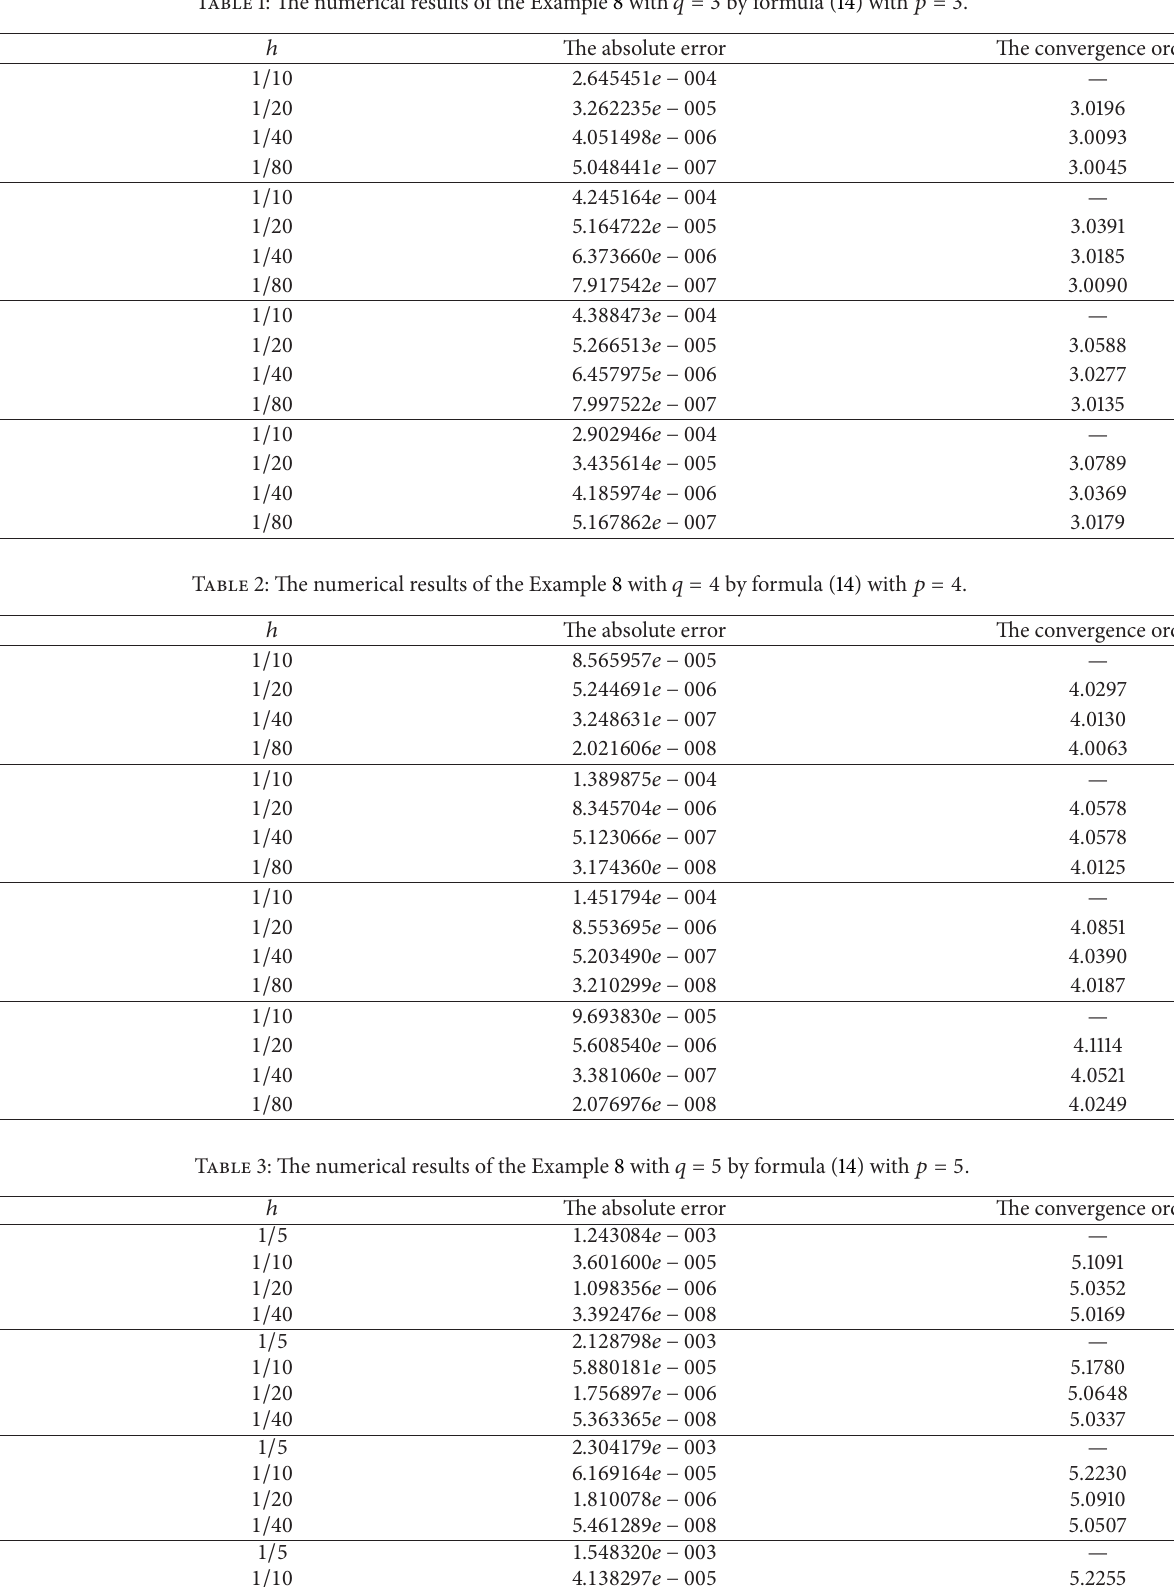
Table 1: The numerical results of the Example 8 with 𝑞 = 3 by formula (14) with 𝑝 = 3 .